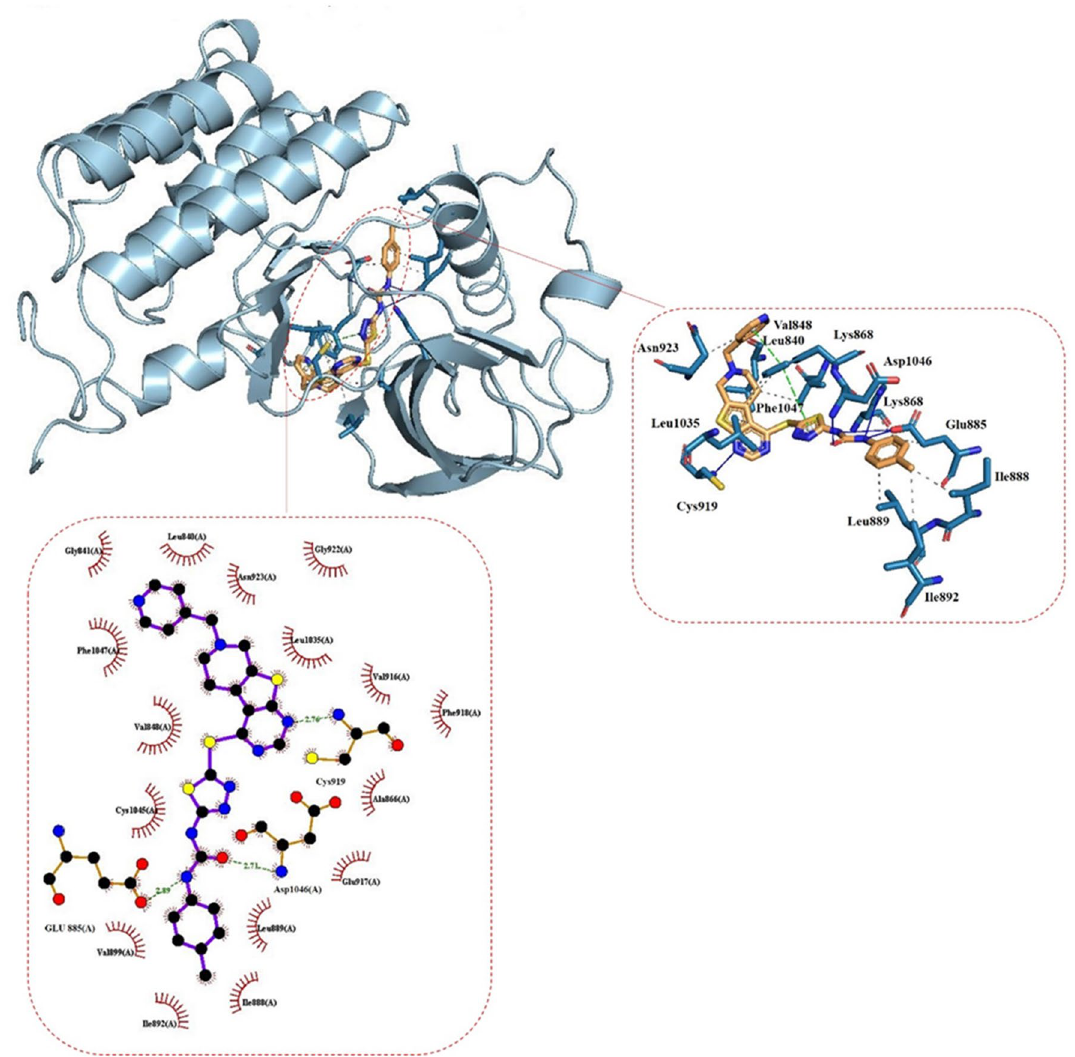
Figure 6. Two-dimensional (2D) and three-dimensional (3D) diagrams of compound 11n in the active site of VEGFR-2 receptor. The hydrophobic interactions, hydrogen bonds and π-stacking interactions are indicated as black-dotted, blue, and green-dashed lines, respectively. The white spheres indicate center of aromatic